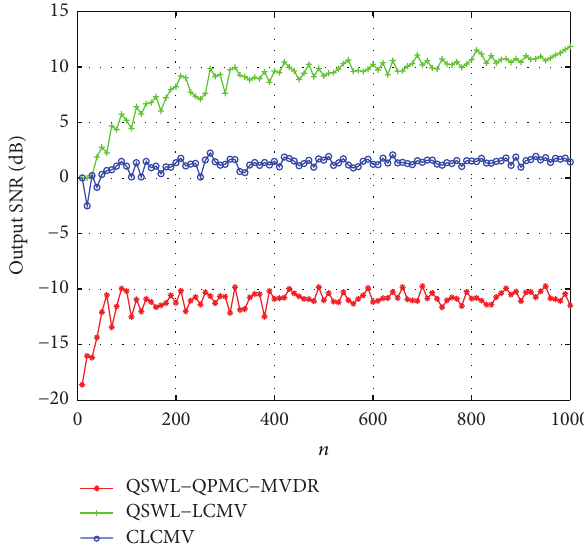
Figure 7: Effect of the number of snapshots at 𝑀 = 6 .